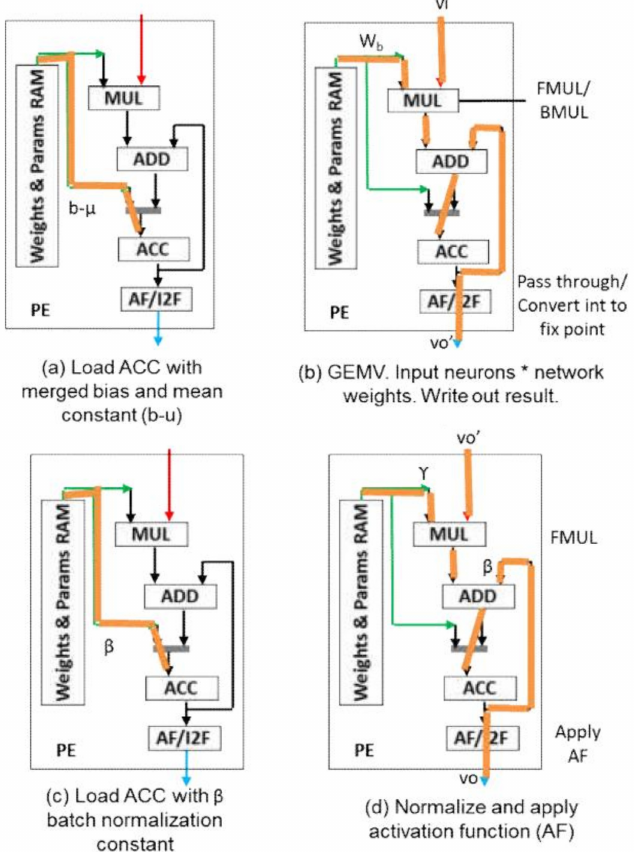
Figure 4. Sequences of operations that a processing element takes to process a BNN layer [24]. (Reprinted with permission from ref. [24]. Copyright 2021